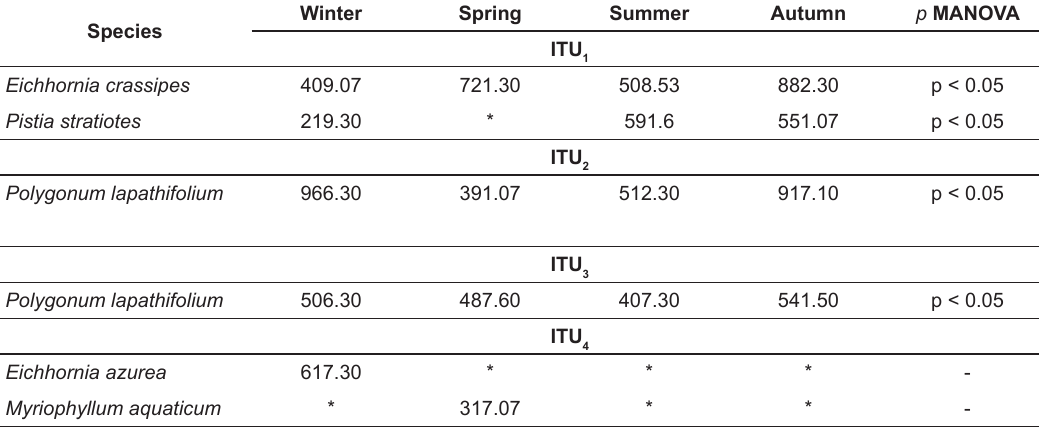
Table 4. Aquatic macrophyte biomass (gDW.m –2 ) in different arms and seasons in Itupararanga Reservoir.